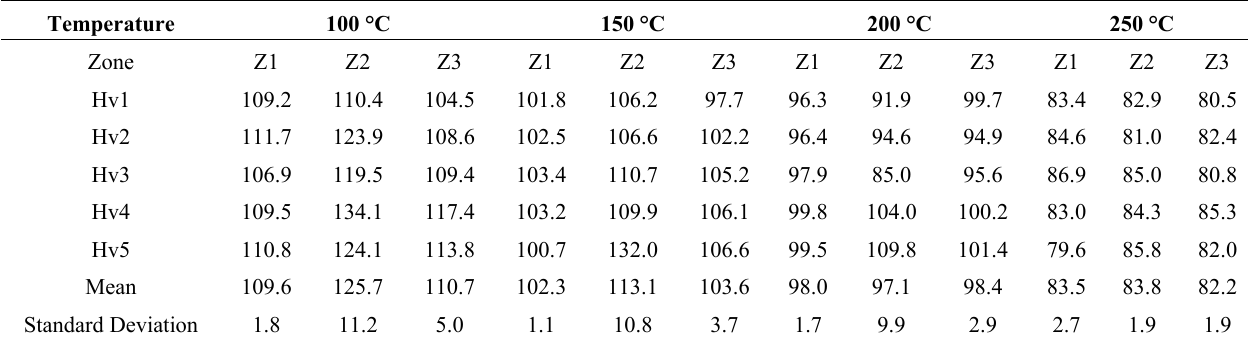
Table 2. Microhardness values for the N2 forged connecting